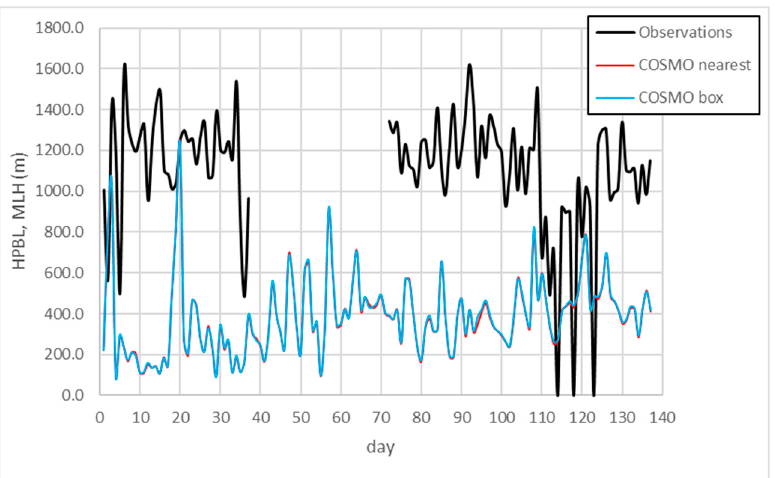
Figure 13. Time series of daily values (m) of planetary boundary layer height (HPBL) provided by the model against mixing layer height (MLH) starting from the backscatter profiles provided by the ceilometer, over the considered period. (Note that in the period 21 February–26 March 2018 observational data were not available.)